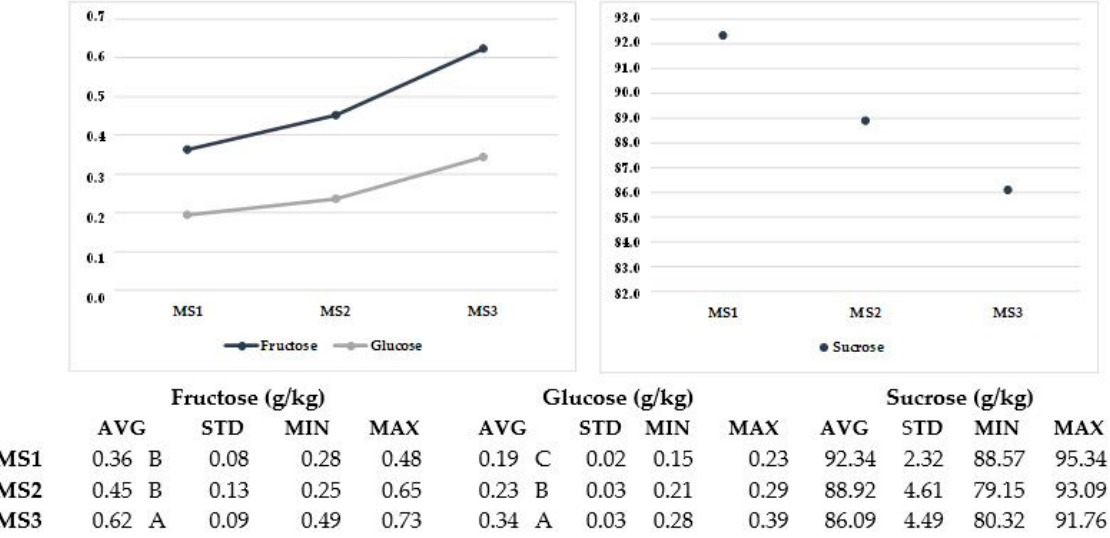
Figure 5. Sugar content by state of maturity. Different letters indicate a difference between averages according to Duncan’s test at 5%. according to Duncan’s test at